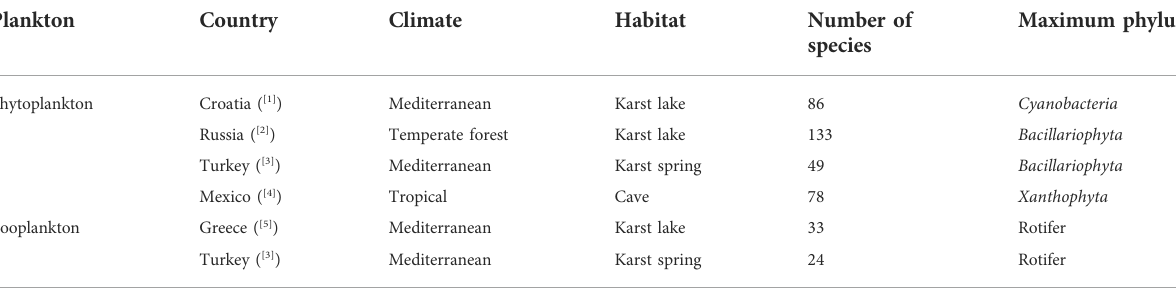
TABLE 4 Comparison of plankton species in karst water under several climate conditions.